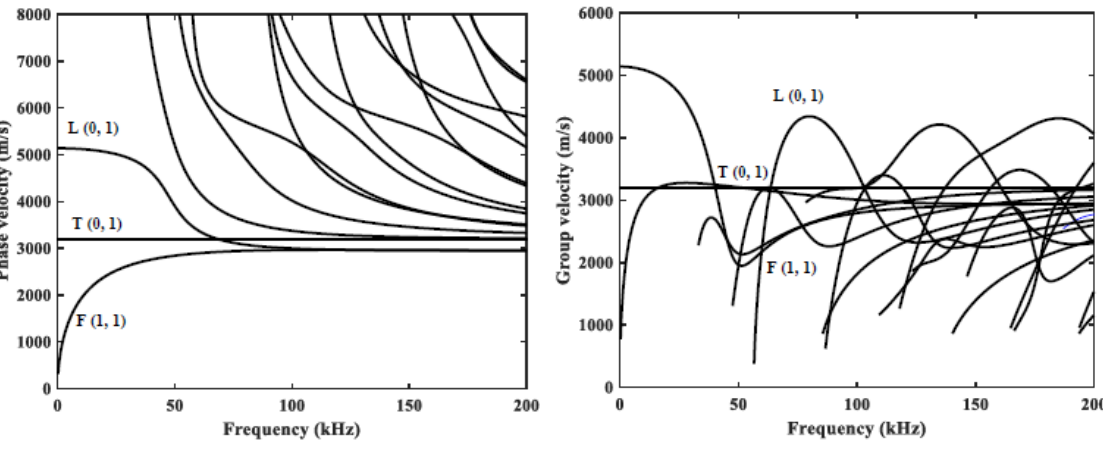
Figure 1. Phase velocities and group